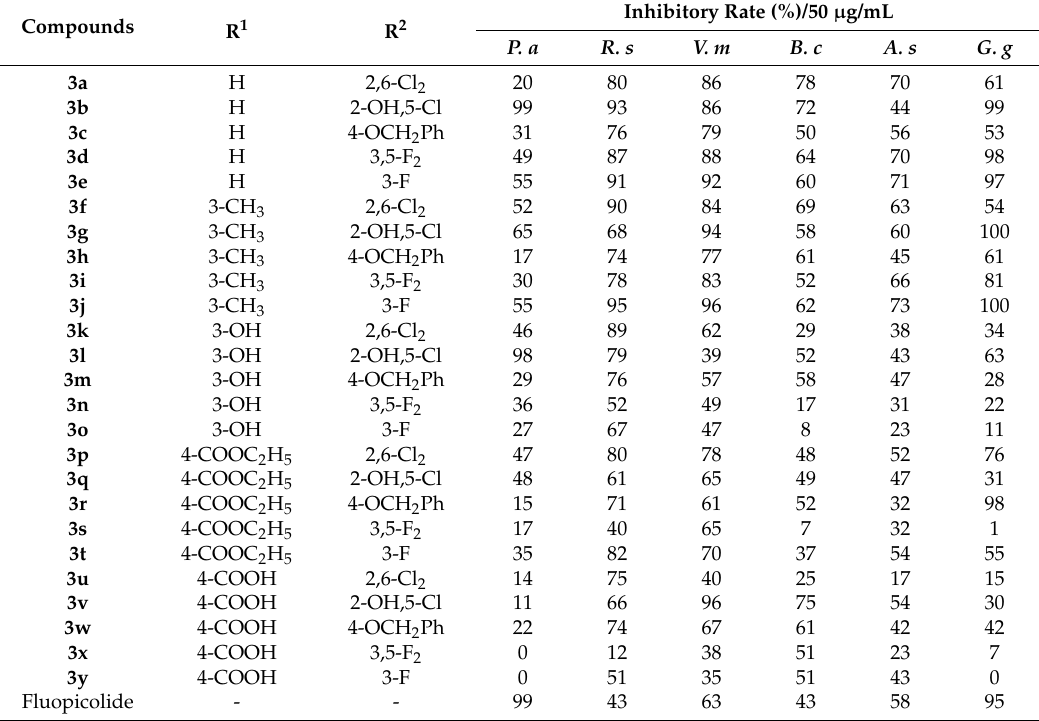
Table 1. In vitro fungicidal activities of the title